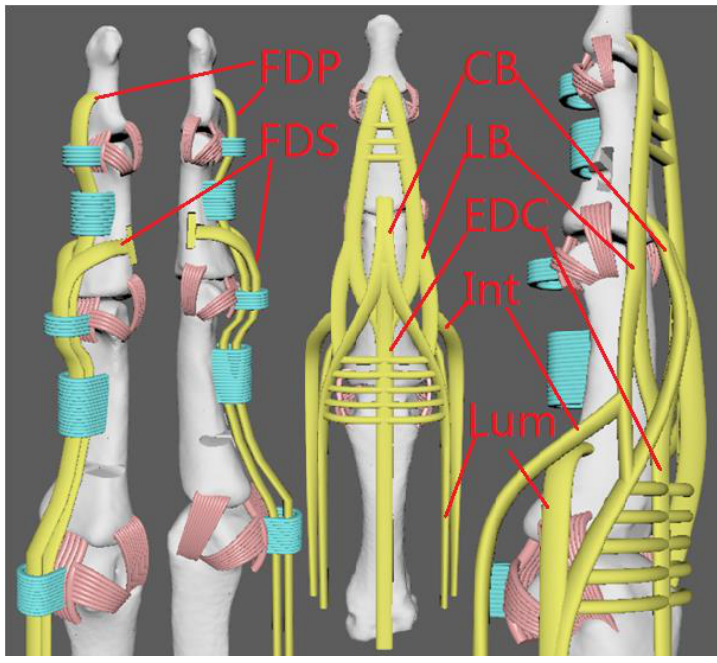
Figure 6. Our robotic hand tendon and pulley system.